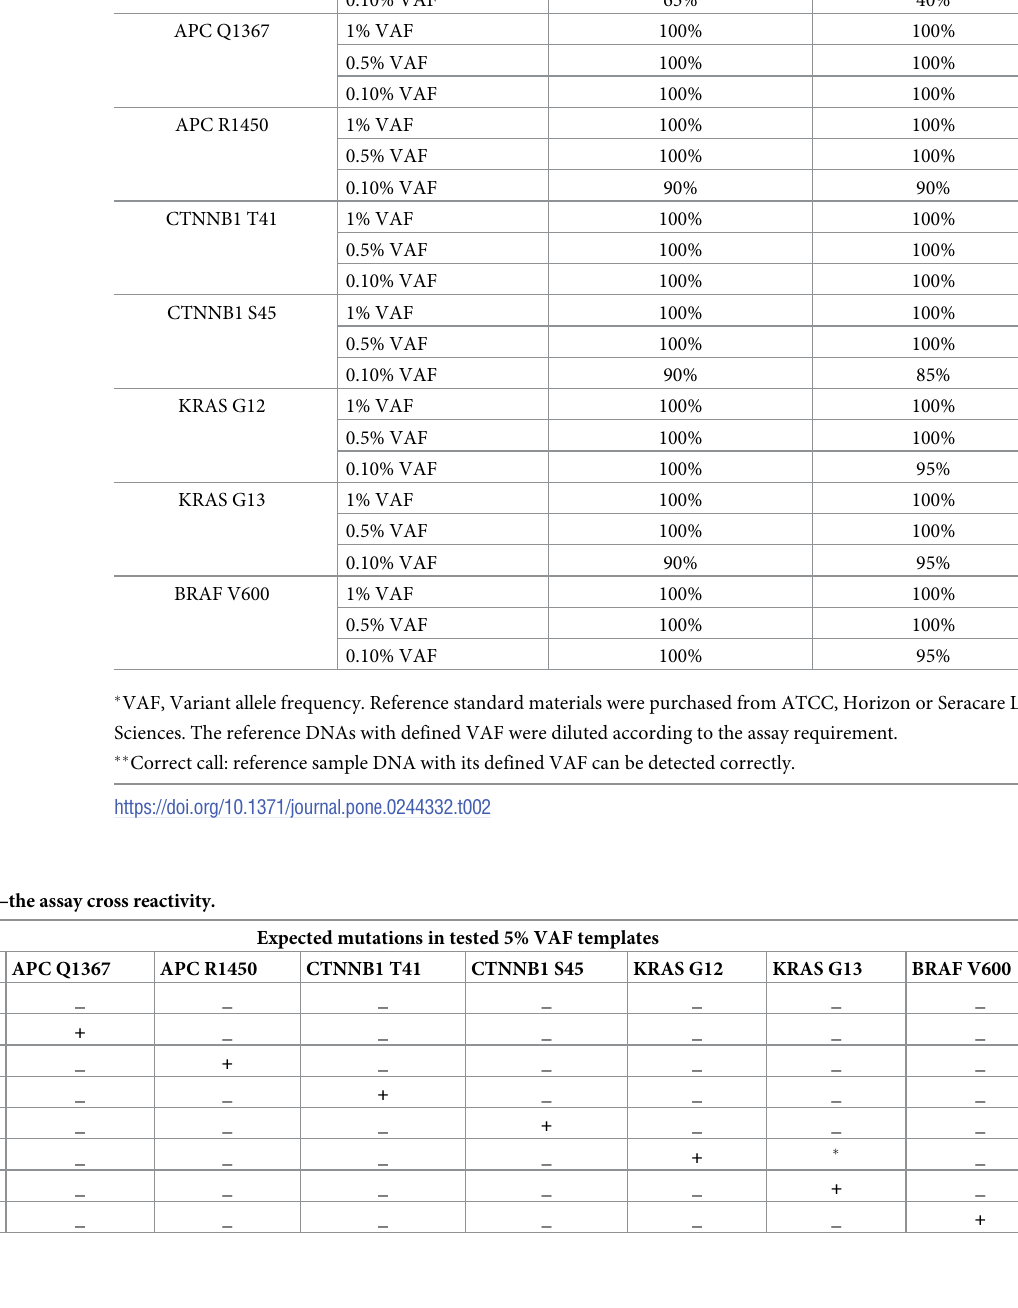
Indicates cross reaction